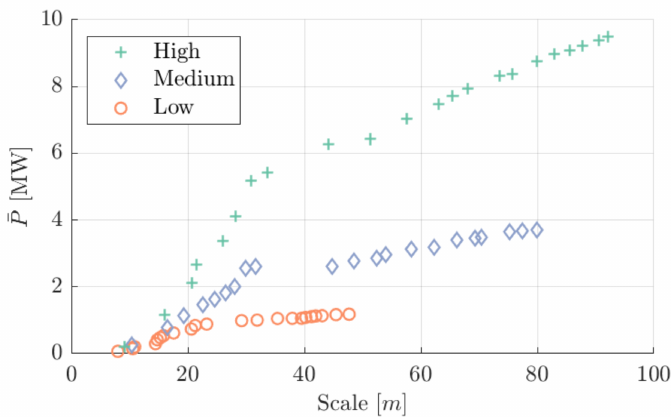
Figure 9. A fundamental relationship example for power extraction vs. scale depending on resource level being high, medium, or low for a cuboid absorbing power in